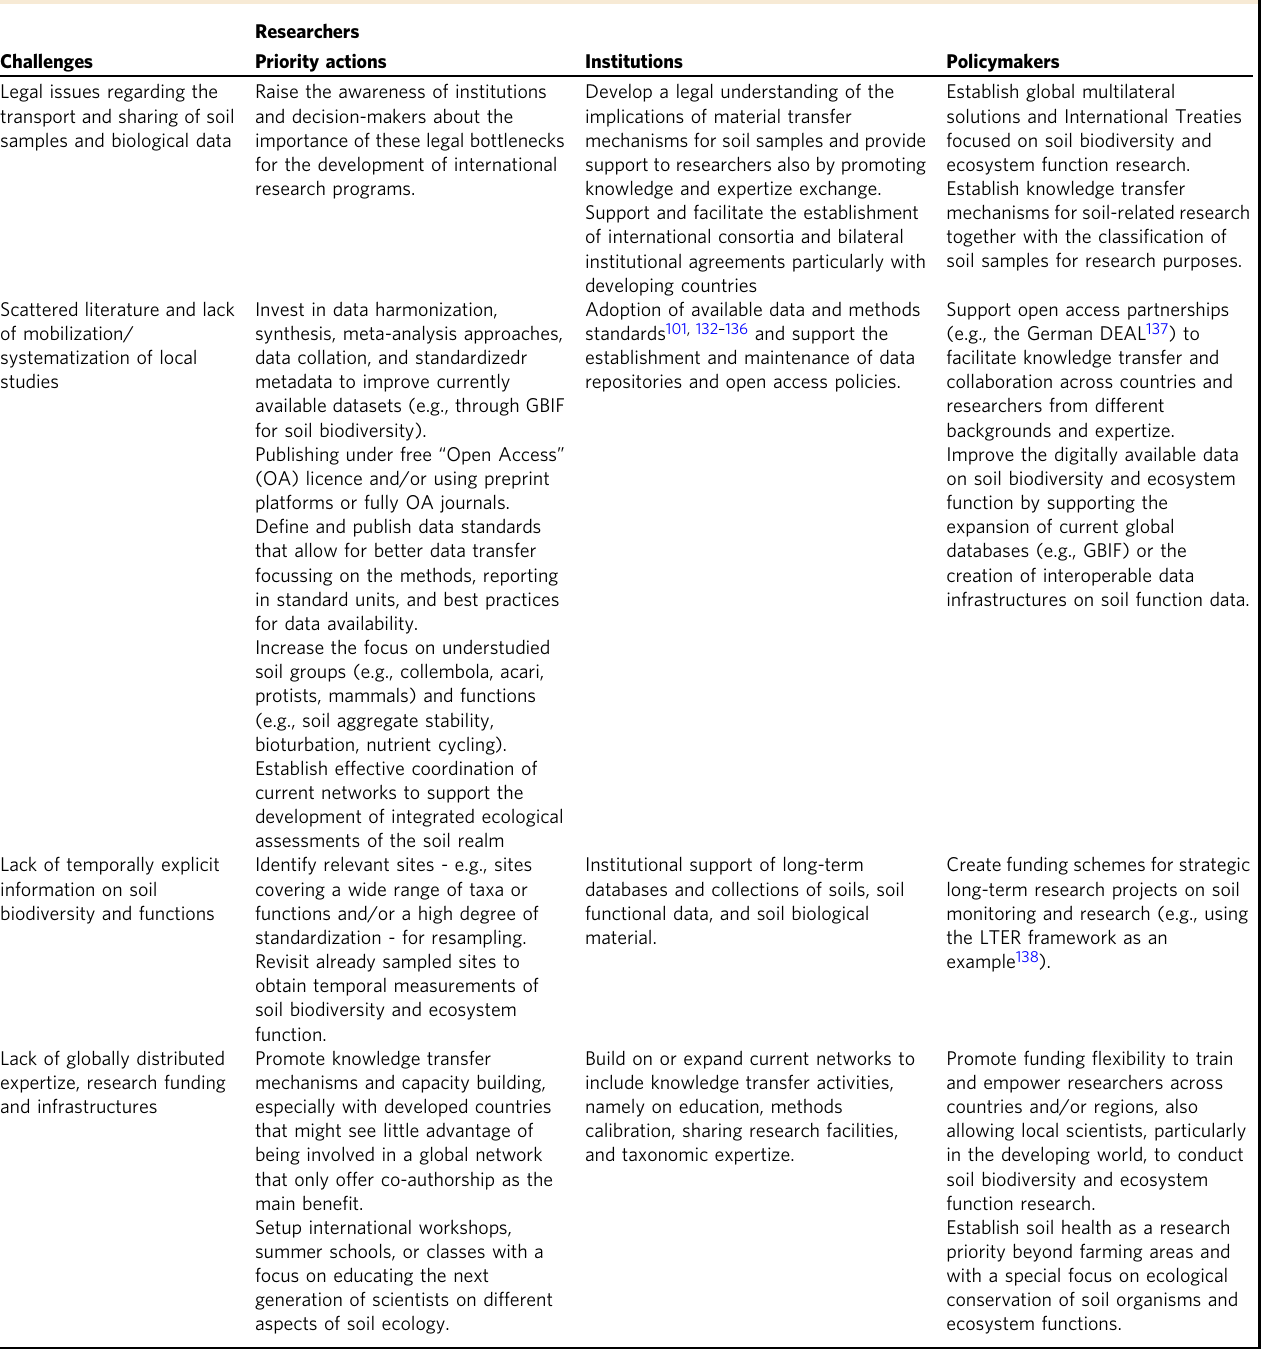
Table 1 Summary of the main obstacles soil ecologists face to create a global soil biodiversity monitoring network and the priority actions to overcome